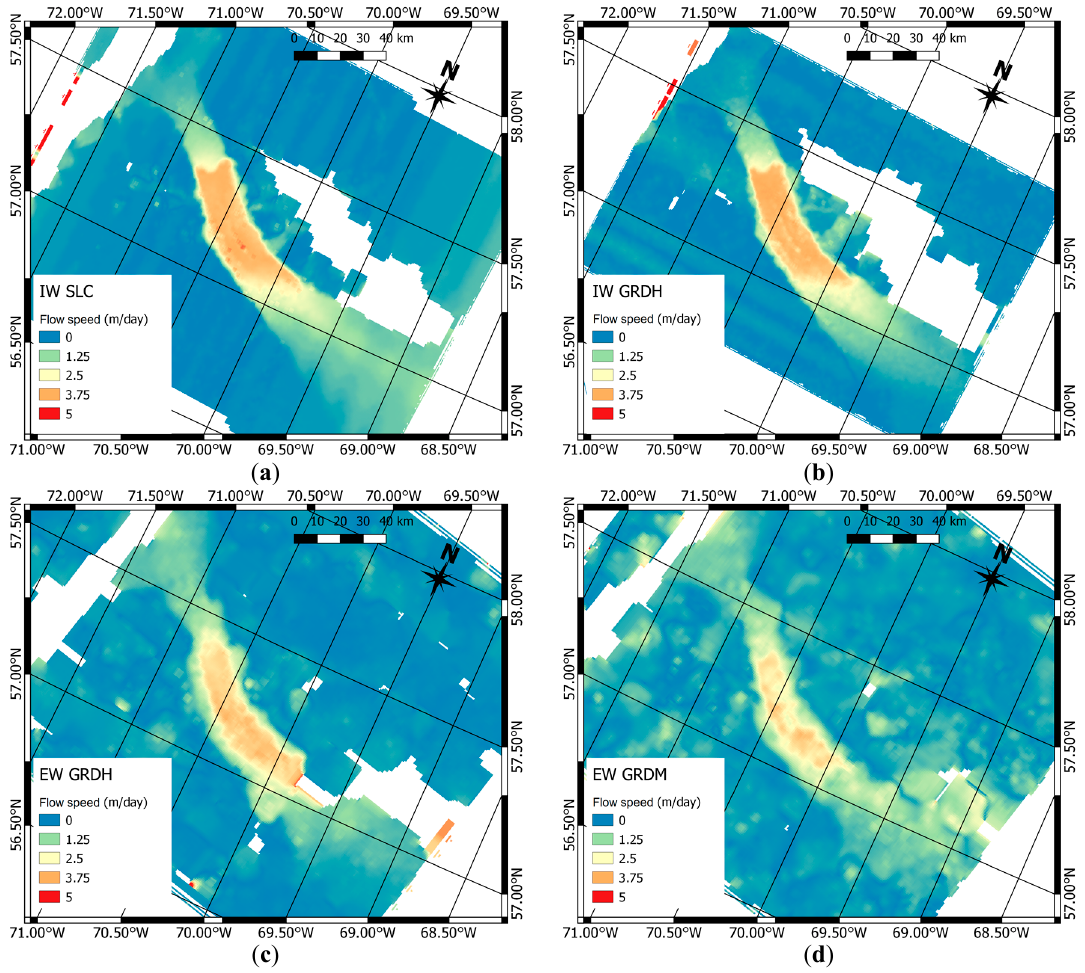
Figure 3. PG, flow speed maps obtained using ( a ) IW SLC, ( b ) IW GRDH, ( c ) EW GRDH and ( d ) EW GRDM images. Observation periods are 6–12 January 2017 for IW images and 1–13 April for EW images.